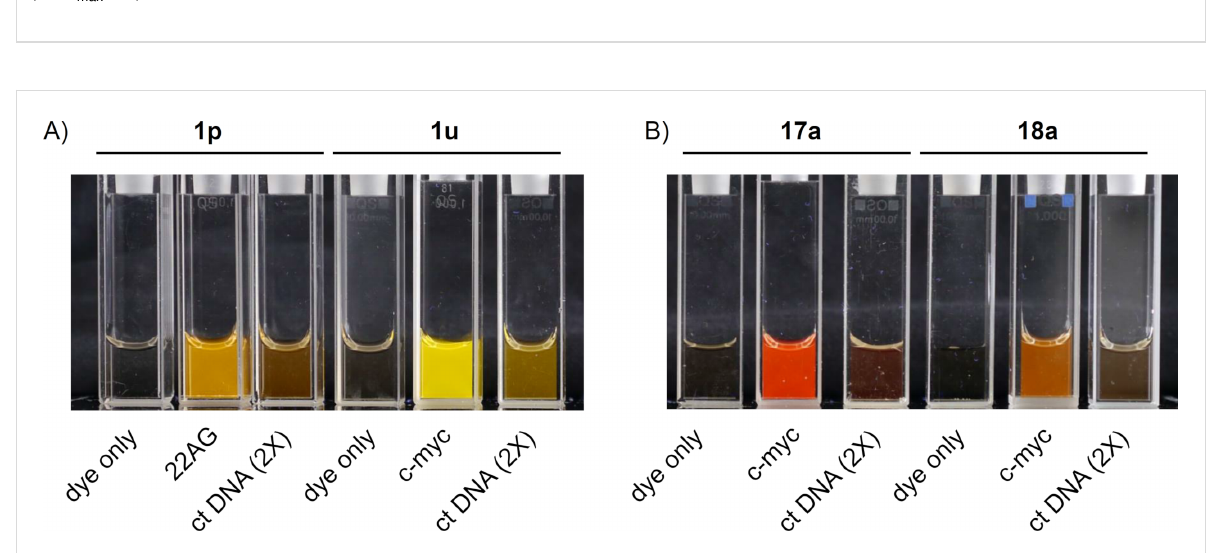
Figure 10: Photographs of solutions of A) distyryl dyes 1p and 1u ; B) mono-styryl dyes 17a and 18a , in the absence or in the presence of G4 ( 22AG or c-myc , 10 µM) or ds DNA (ct DNA, 250 µM bp) upon bottom illumination with UV light ( λ = 312 nm); in all cases, c (dye) = 5 µM in K-100 buffer.